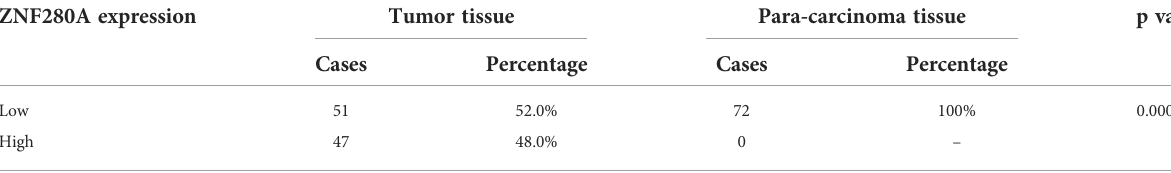
TABLE 1 Expression of ZNF280A in colorectal cancer tissues and para-carcinoma tissues in